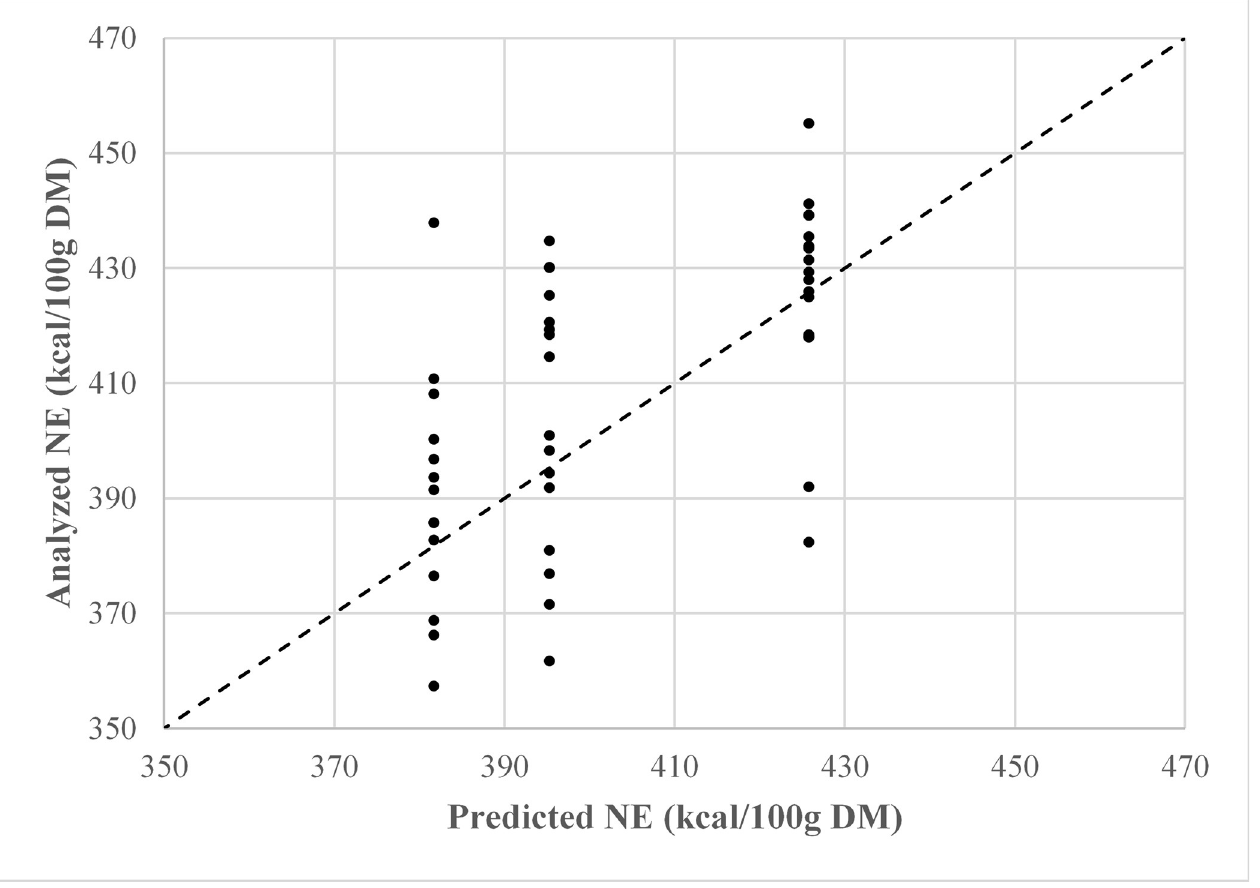
Fig 3. Observed versus predicted plot of dietary net energy using equation 5 (NE = (.693 × ME) + (3.375 × CP)– 74.533); R 2 = .330.